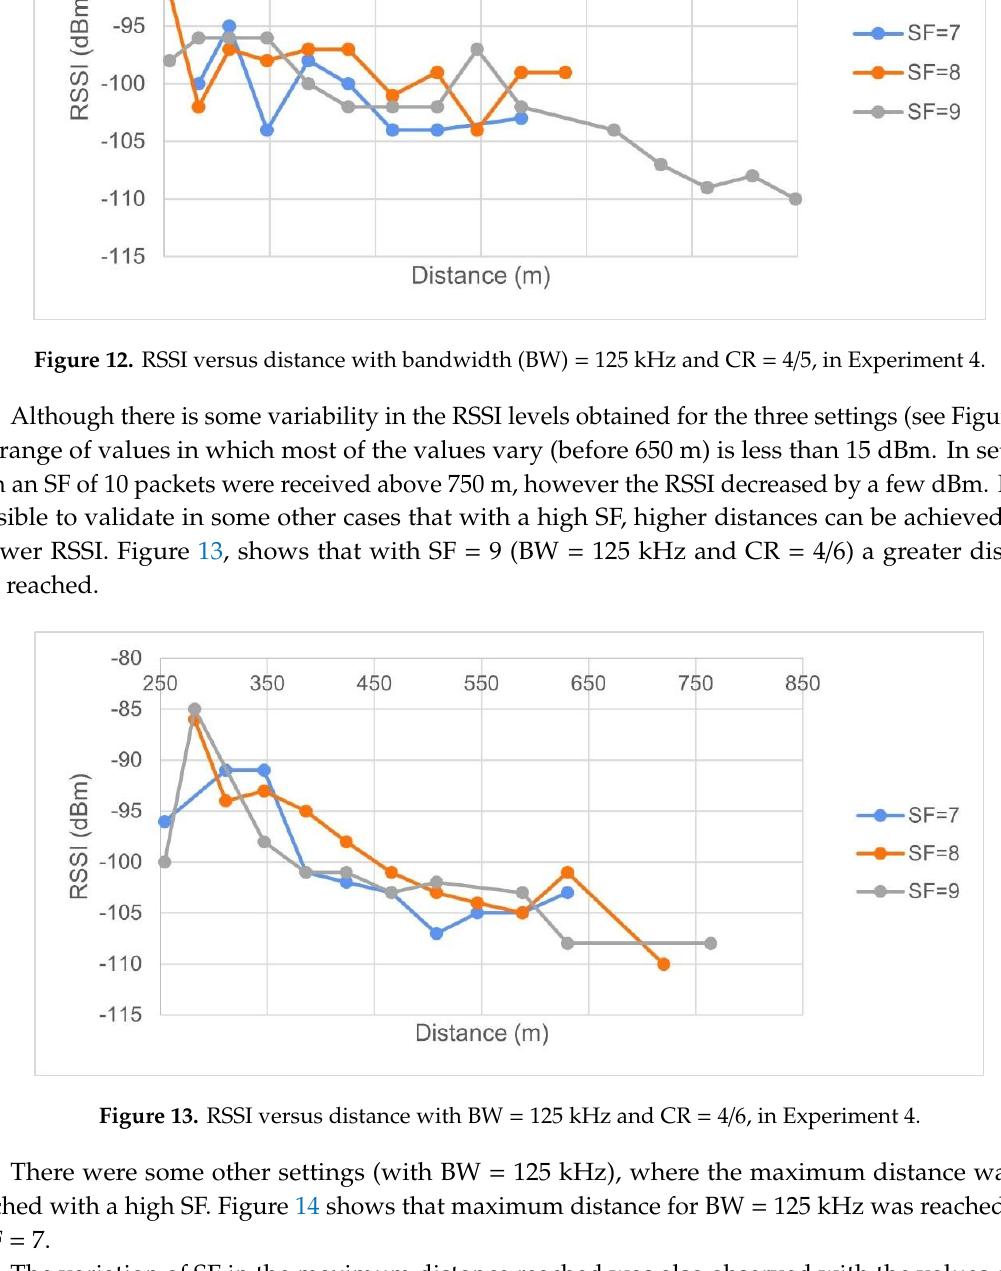
Figure 14. RSSI versus distance with BW = 125 kHz and CR = 4/7, in Experiment 4. The variation of SF in the maximum distance reached was also observed with the values of BW equal to 250 kHz and 500 kHz, where in some cases the maximum distance was reached with SF = 9 or SF = 10, but in other cases it was reached with SF = 7. With respect to percentage of received packets, no settings yielded 100% reception. A total of 27% of the settings featured a reception rate between 99% and 75%; 10% of the settings featured a reception rate below 50%. The baseline setting was the best for this experiment. It obtained an average RSSI value of –103 dBm, 94% packets received, and a maximum distance of 848 m.